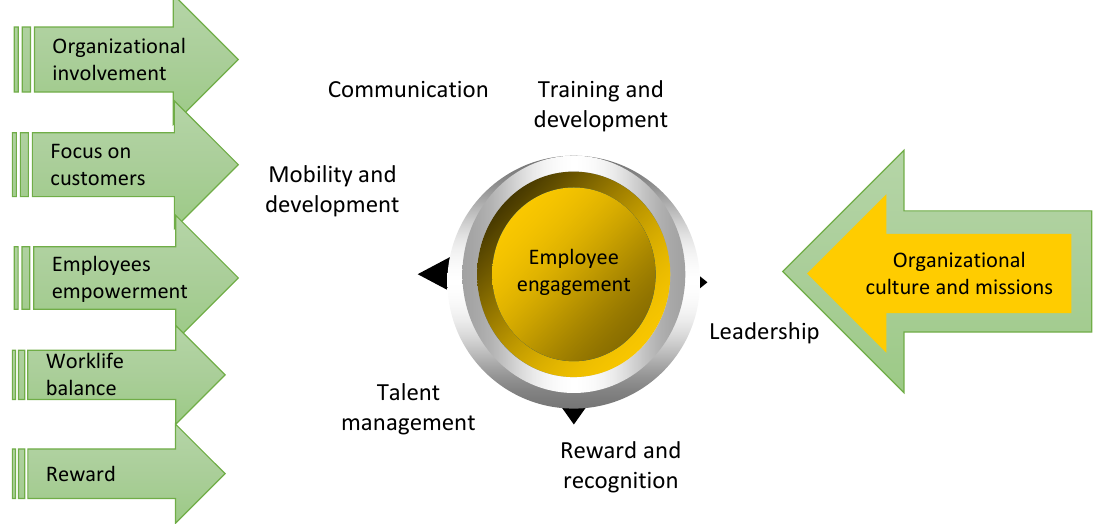
Figure 1. The roles of culture in